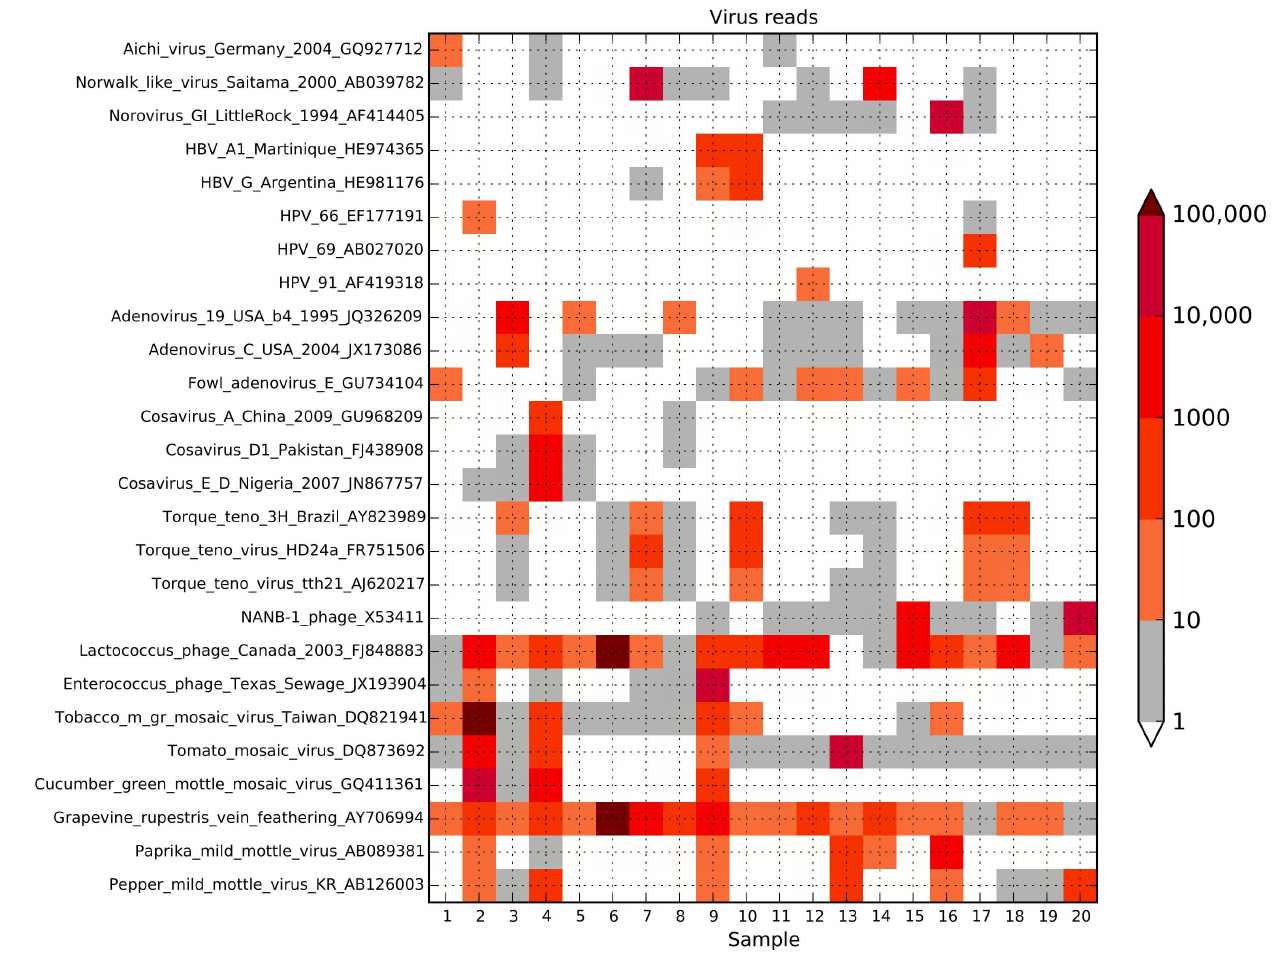
Figure 6. Quantitation of specific virus reads in each of the 20 samples. All reads for each sample (see Table 1 for total number of reads per samples) were mapped to the indicated viral genomes using MUMmer [31]. The number of reads mapped to each virus (normalized for total reads in each sample) is depicted by color (see color bar scale to right of figure).